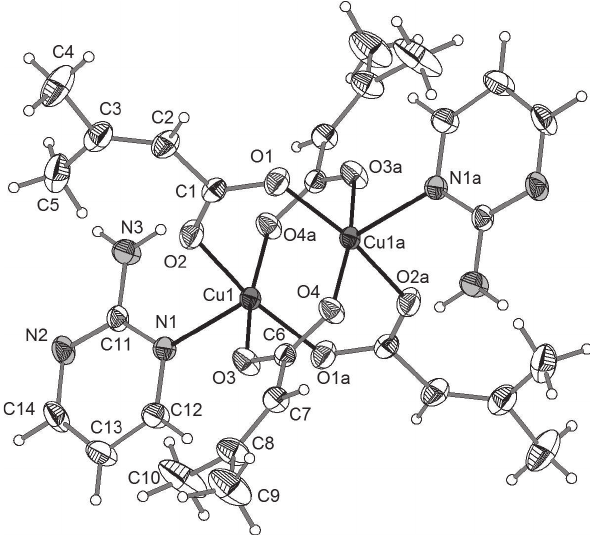
Table 1: Data collection and